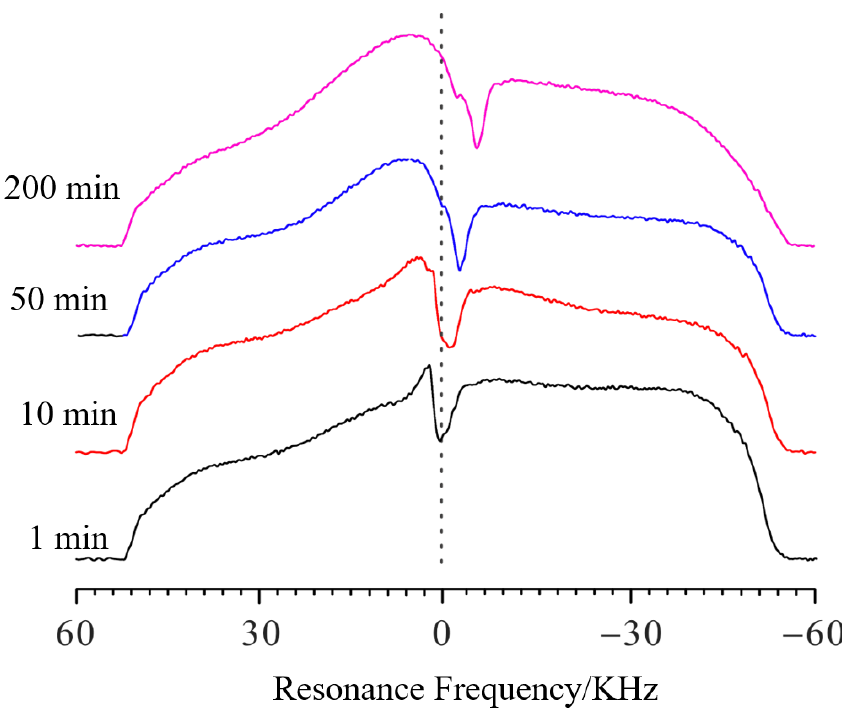
Figure 4. The NMR profile spectra of PMAB gels at different swelling times (25 °C). The black line represents 1 min, the red line represents 10 min, the blue line represents 50 min, and the pink line represents 200 min.